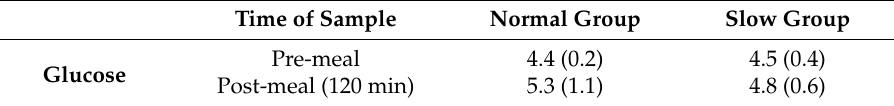
Table A6. Glucose levels at baseline and 120 min post-meal (mean; SD).